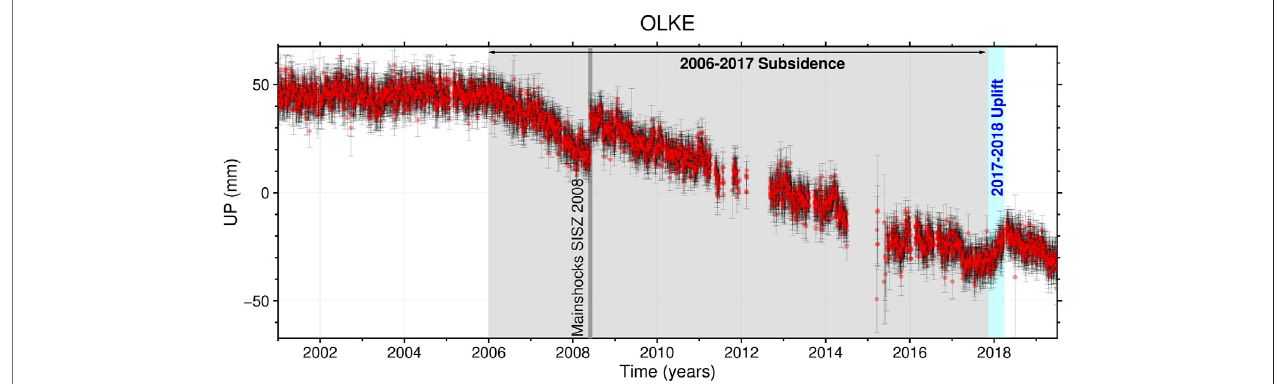
FIGURE 2 | Time series of vertical displacements at the continous GPS station OLKE (Jan 1, 2001 – Jun 30, 2019). The time series has been corrected for a linear trend and seasonal signals estimated between January 2001 and January 2006. OLKE shows vertical and horizontal displacements consistent with a de fl ating source between 2006 and 2017 and a subsequent uplift episode between 2017 and 2018 consistent with an in fl ating source. The brief episode of uplift (2017 – 2018) comes afteranextendedperiodofsubsidence(2006 – 2017;Juncuetal.,2017).Detailsonthedetrending,andfulltimeseriesofthestationcanbefoundinSupplementary